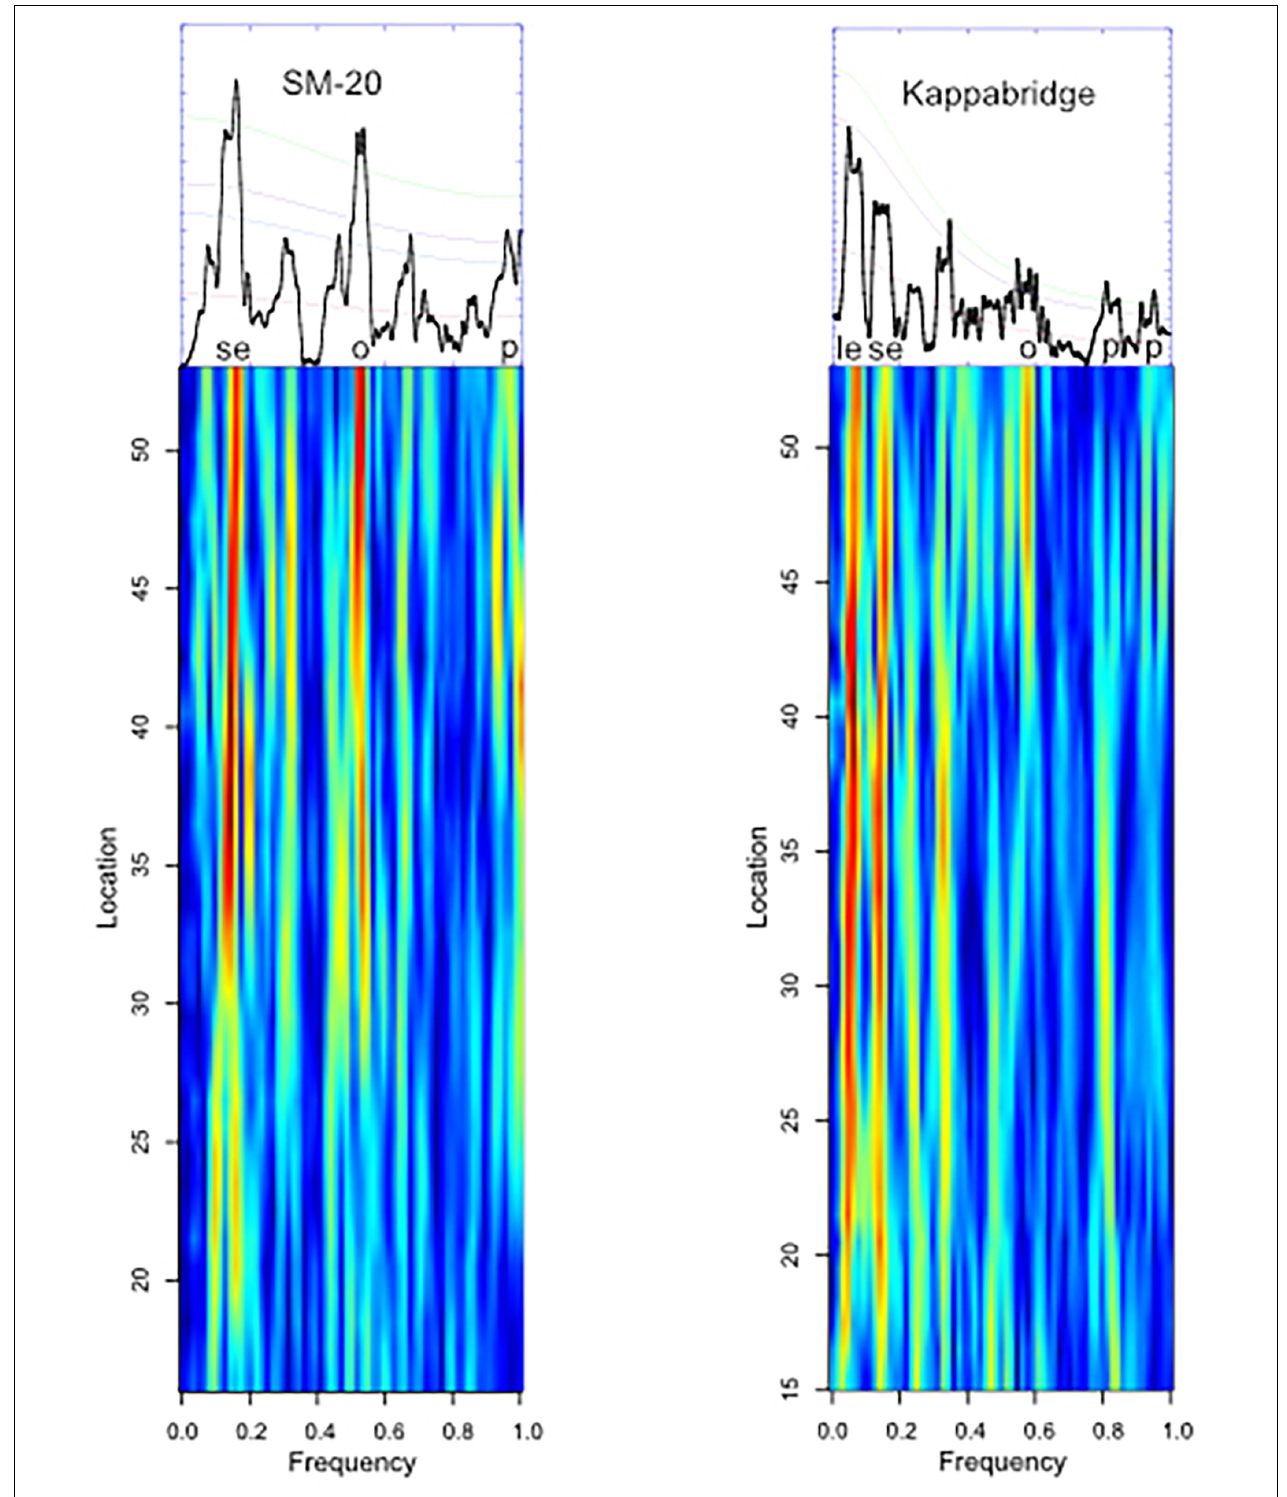
FIGURE 8 | Evolutionary spectrograms calculated using Astrochron (Meyers, 2014) for the SM-20 (Left) and the Kappabridge measured samples (Right) . The MTM calculated power spectrum for each series (using SSA-MTM) is shown at the top of each evolutionary spectrogram with Milankovitch spectral peaks labeled (le = long eccentricity, se = short eccentricity, o = obliquity, p = precession). The evolutionary spectrograms were calculated with a window of 30 m and a step of 1 m. They show that the sediment accumulation rate does not vary significantly through the section although the power of the different frequencies does vary.